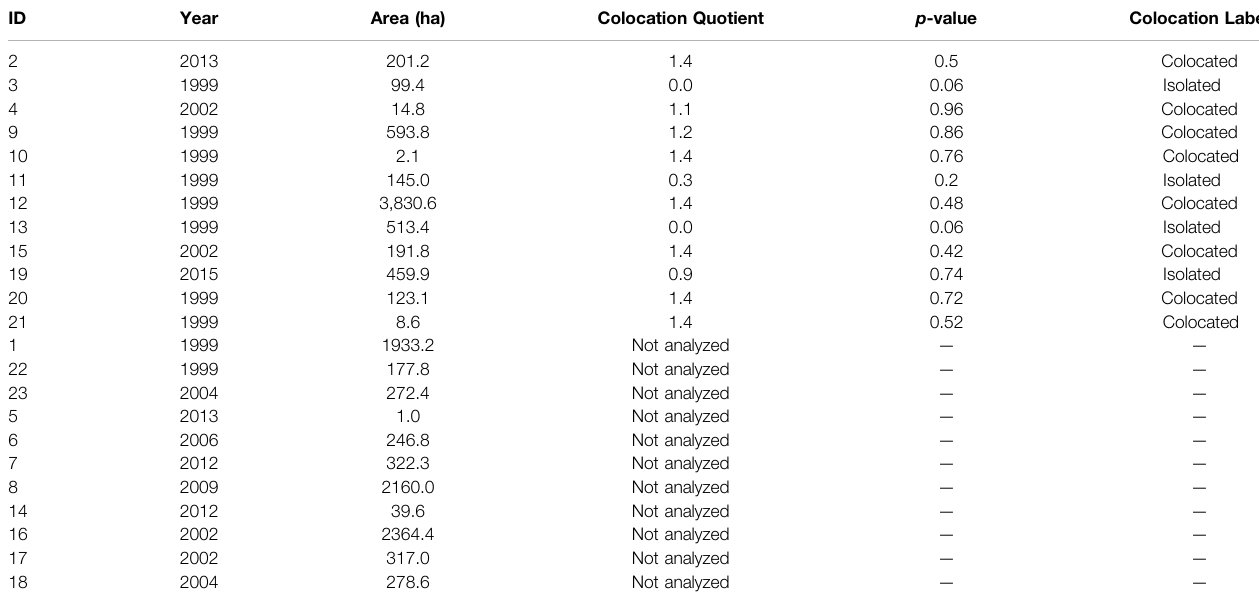
TABLE 2 | Colocation Analysis Summary: relation between wild fi res and